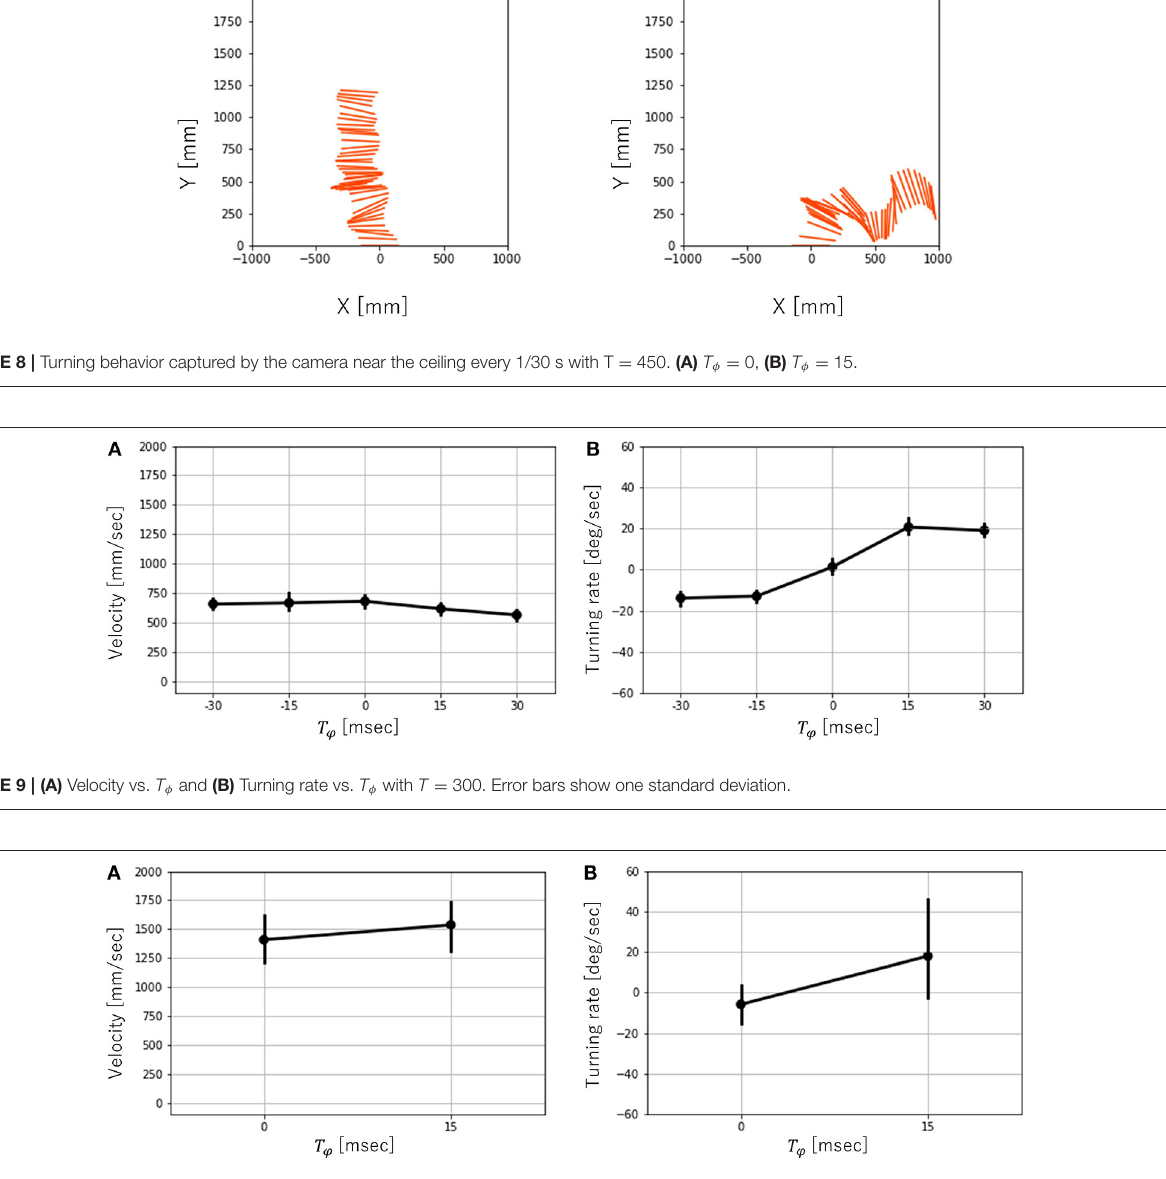
FIGURE 10 | (A) Velocity vs. T φ and (B) Turning rate vs. T φ with T = 450. Error bars show one standard deviation. It is noted that the mean and the standard deviation are calculated using the data the robot successfully ran.